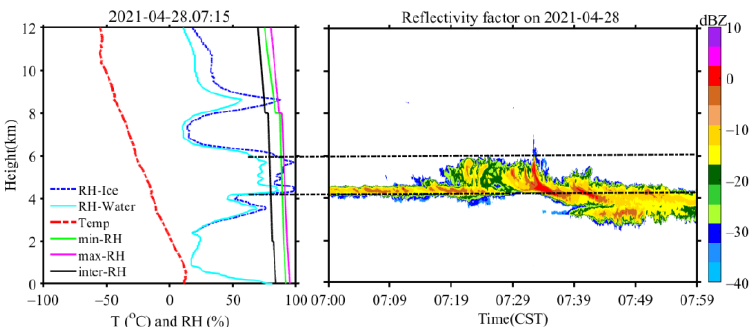
Figure 2. Middle cloud detected by the radiosonde and MMCR on 28 April 2021 (radiosonde temperature and RH profile ( left ), reflectivity factor THI from the MMCR ( right )).